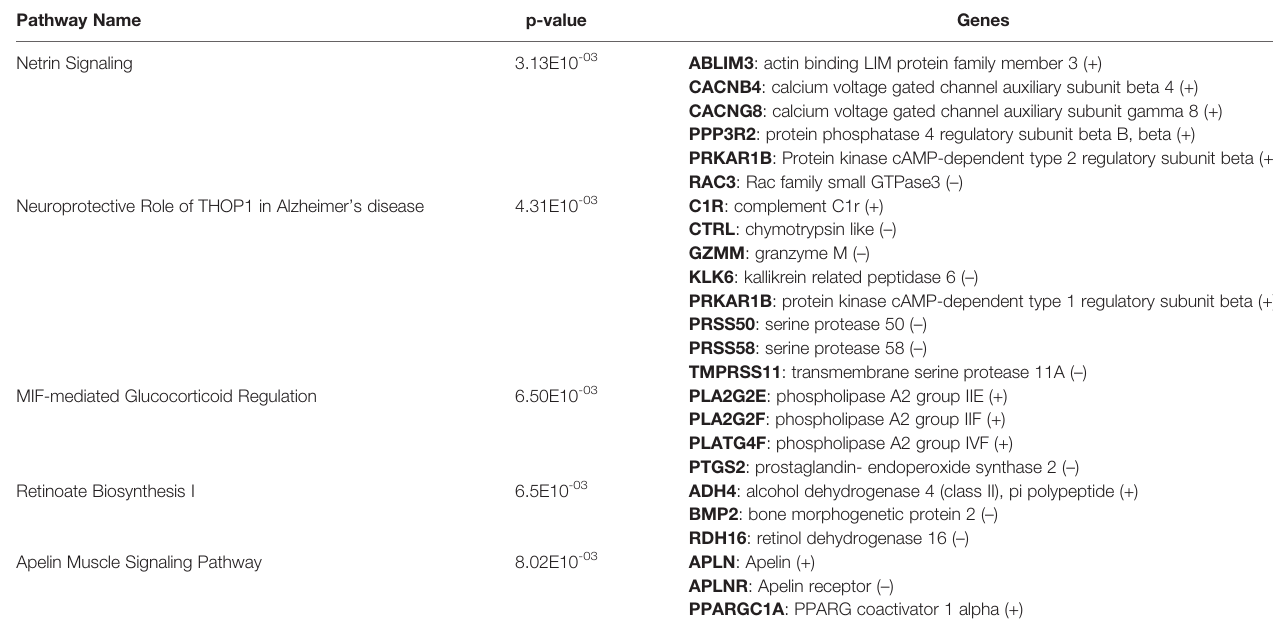
TABLE 3 | C. neoformans leads to the activation of highly speci fi c metabolic pathways in female Ly6c - antifungal monocyte-like macrophages. Pathway Name